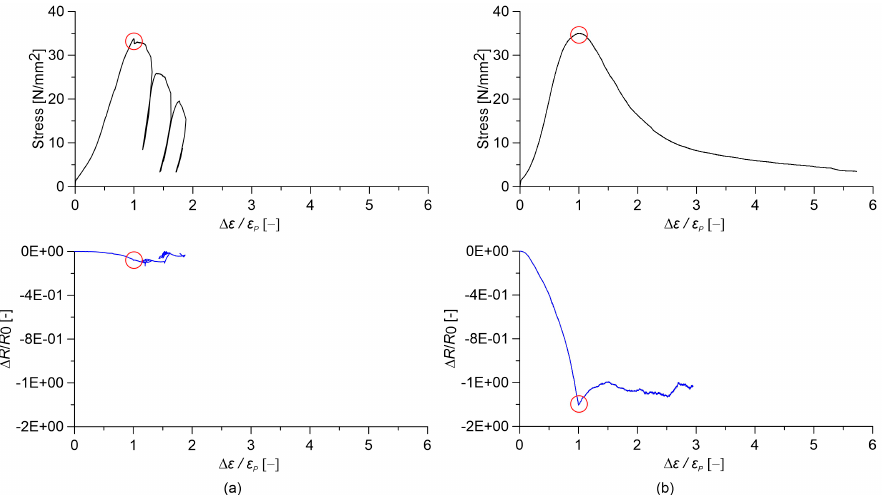
Figure 13. Comparison between stress and relative change in electrical resistance versus relative applied strain for concrete specimens obtained from destructive tests (the circle indicates the peak stress point). Concrete with ( a ) 0.00% MWCNTs and ( b ) 1.00% MWCNTs.